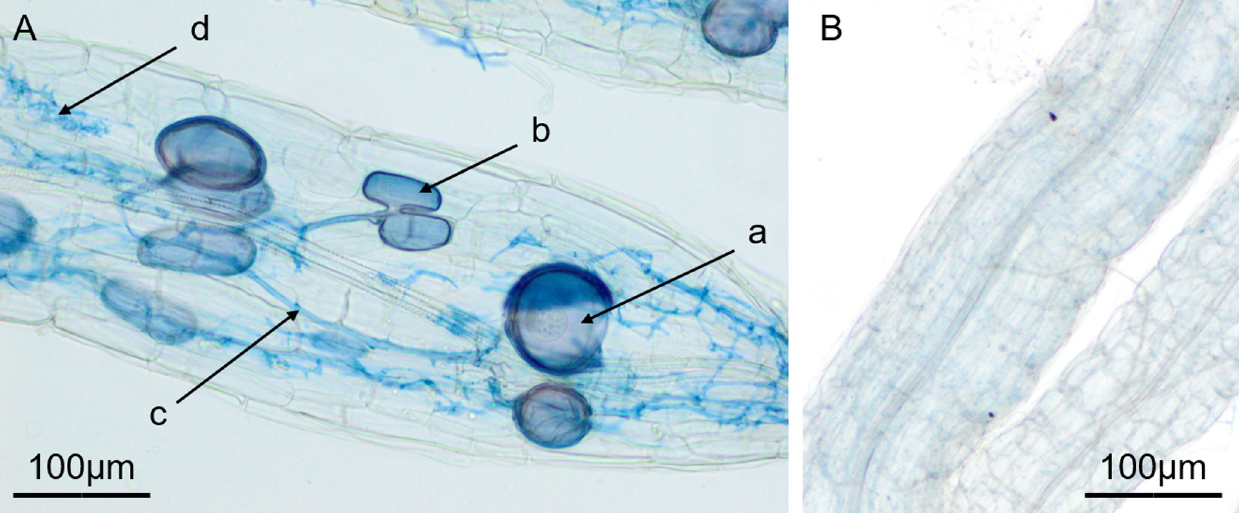
Fig 1. AM structures detected in mycorrhizal root (A) and root of non-mycorrhizal seedlings (B). a: spore; b: vesicle; c: hypha; d: arbuscule.